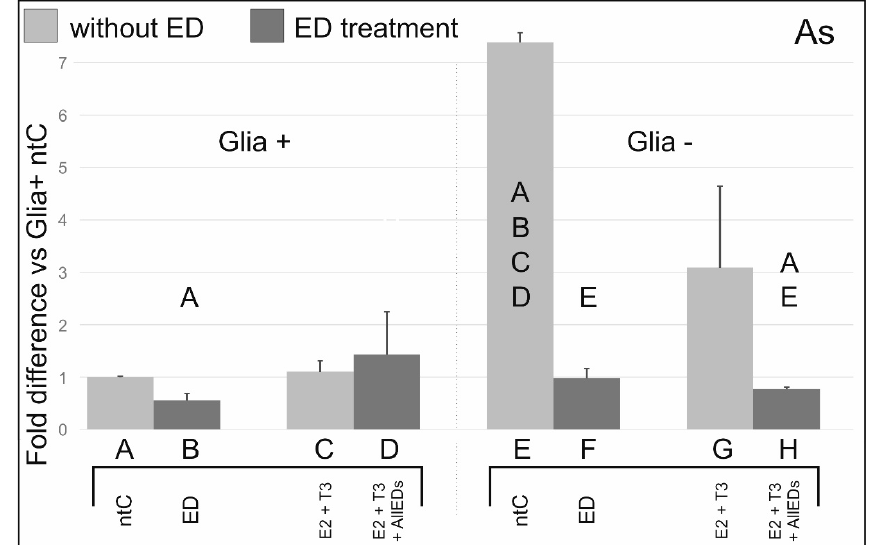
Figure 3. Effects of arsenic (As) with, and without, 17beta-estradiol (E2) and triiodo-thyronine (T3), on ER β mRNA expression. ER β mRNA expression levels after As and As + E2 + T3 treatments showed a pattern comparable in trends with that found in BPA studies in Glia+ and to those seen in Zea studies in Glia − . Le tt ers in and above the columns indicate significant differences ( p ≤ 0.05) from columns below.